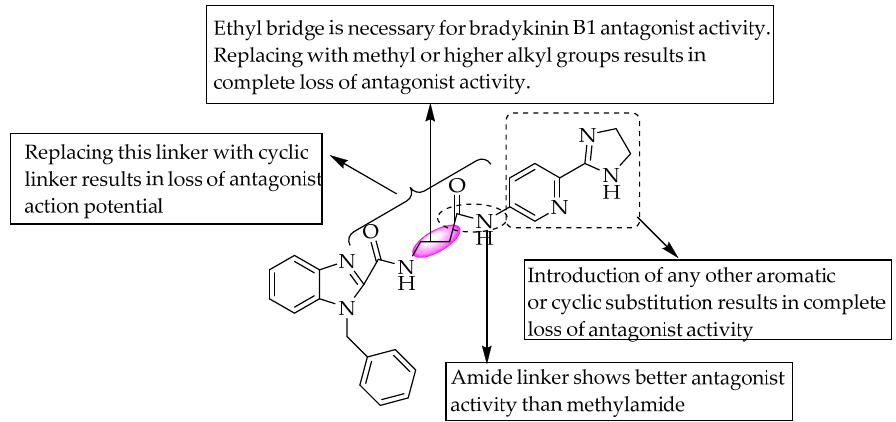
Figure 10. SARs of 2-substituted N-benzyl benzimidazoles.